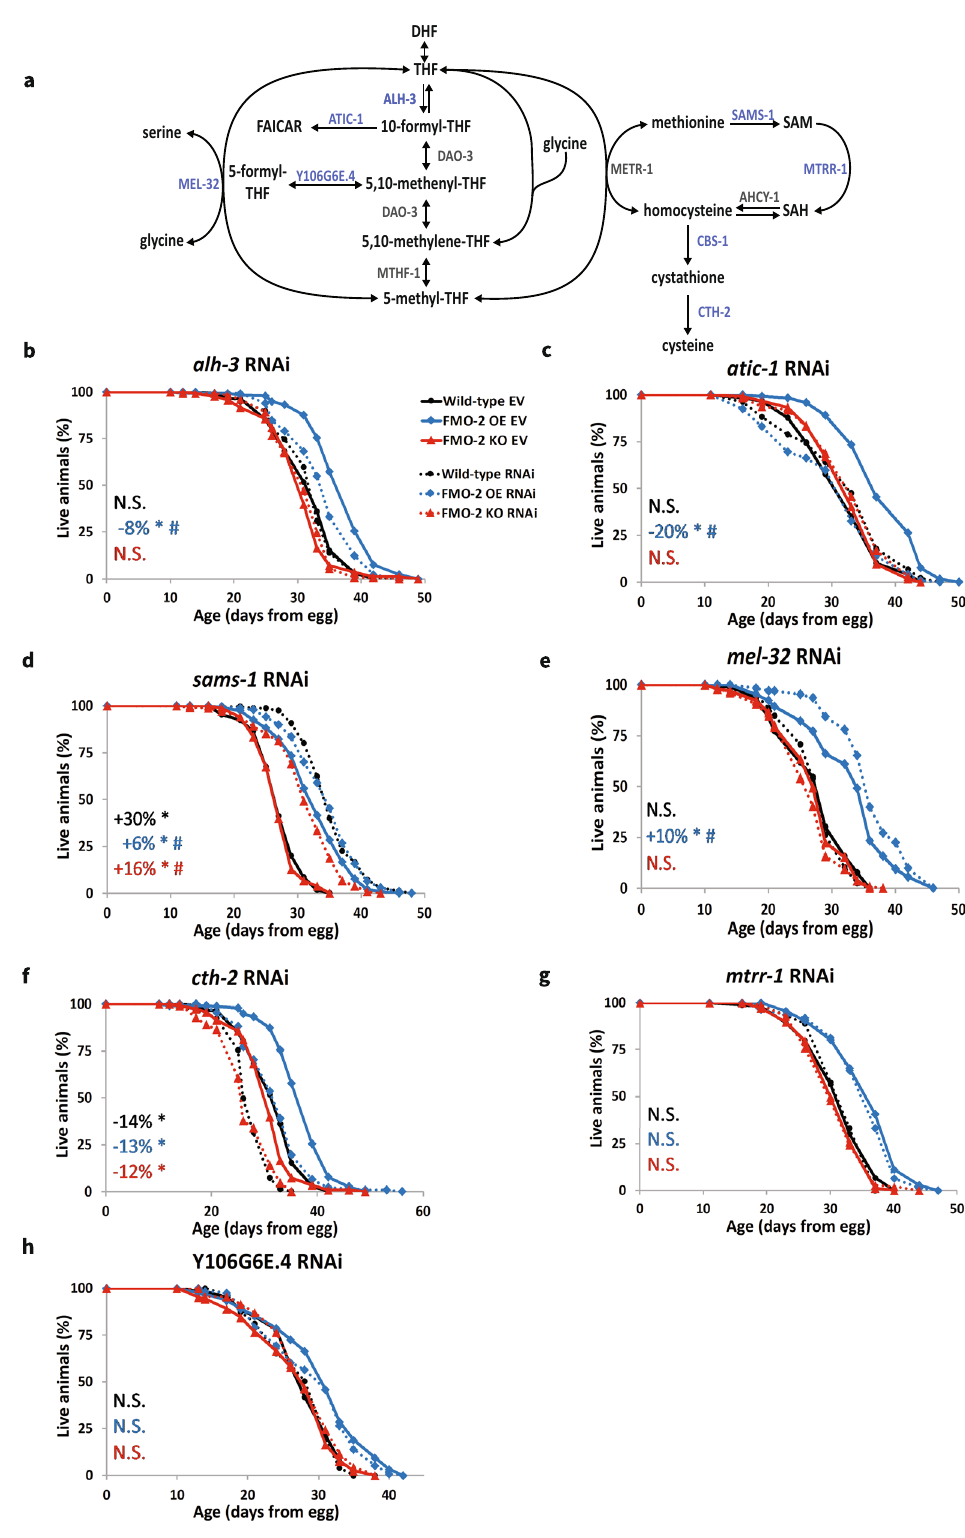
fi gures.Blackcircle=wildtype,bluediamond=FMO-2OE,andredtriangle=FMO-2 KO. Solid line = EV and dotted line = RNAi. * denotes signi fi cant change in mean lifespanat p <0.05usinglog-rankand#denotessigni fi cantinteractionbetweenthe RNAi of interest and fmo-2 genotype at p <0.01 using Cox regression analysis. N.S.=not signi fi cant. Statistics are in Table 1, Supplementary Table 5, and Supple- mentary Data